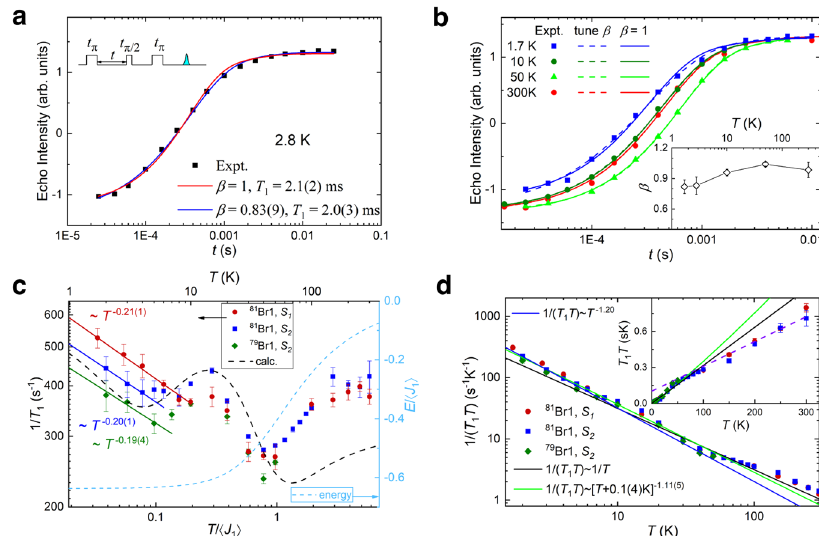
Fig. 4 Nuclear spin-lattice relaxation of YCu 3 (OH) 6.5 Br 2.5 . a A representative T = 2.8 K spin-lattice relaxation of Br1 measured by an inversion recovery method, fi tted to the stretched-exponential function with fi xing β = 1 (red) and tuning β (blue). The pulse sequence for T 1 measurements is depicted in the inset. b The same fi ts to the relaxation data measured at other selected temperatures. The inset shows the fi tted stretching exponent β . c Temperature dependence of 81 Br1 nuclear spin-lattice relaxation rate 1/ T 1 measured on the sample S 1 at a fi eld μ 0 H ∥ = 10.75 T, as well as 81 Br1 and 79 Br1 1/ T 1 measured on S 2 at μ 0 H ∥ = 10.75 and 11.59 T, respectively. The colored lines present the power-law fi ts to the experimental data below ~ 10 K ~ 0.2 〈 J 1 〉 , the dashed black and blue lines are the 1/ T 1 and energy (per site), respectively, calculated by using the random kagome Heisenberg antiferromagnet model of YCu 3 (OH) 6.5 Br 2.5 . d The Curie (~ T − 1 , black lines) and critical (~( T − T c ) (cid:3) α 0 (cid:3) 1 , the critical temperature T c = − 0.1 ± 0.4 K, green lines) fi ts to 1/( T 1 T ) at 1.7 ≤ T ≤ 300 K. The blue line is the low- T power-law dependence as shown in c . The inset shows the T 1 T vs T plot, where the dashed violet line displays the antiferromagnetic Curie-Weiss behavior ( T 1 T ~ T + 〈 J 1 〉 , with coupling 〈 J 1 〉 ~ 50 K). The T 1 data presented in c and d are obtained from the single-exponential fi ts (i.e., β = 1, see a and b ), and the stretched-exponential fi ts are made only for comparison in a and b . Error bars on the experimental data points show a standard error from fi t, and the error bars in a and b are